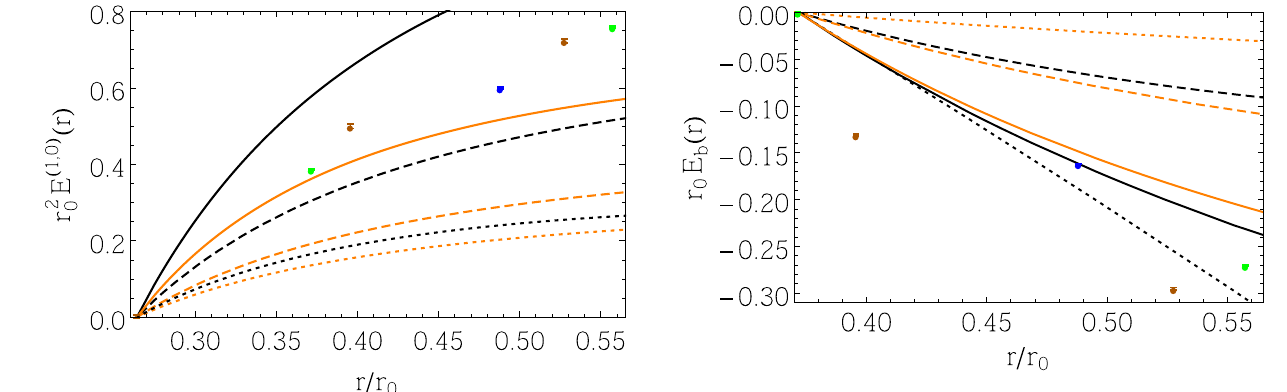
Fig. 6 Comparisontothelatticedatafor E b .Thesolidlinescorrespond to the LO (orange) and NLO results (black) at fixed scale ν = 2 × 1 / 0 . 371627 r − 1 . The dashed lines correspond to the LO (orange) and 0 NLO results (black) setting ν = 4 / r . The dotted lines correspond to the LL (orange) and NLL results (black) setting ν us = C A α(ν)/ r and ν = 4 /